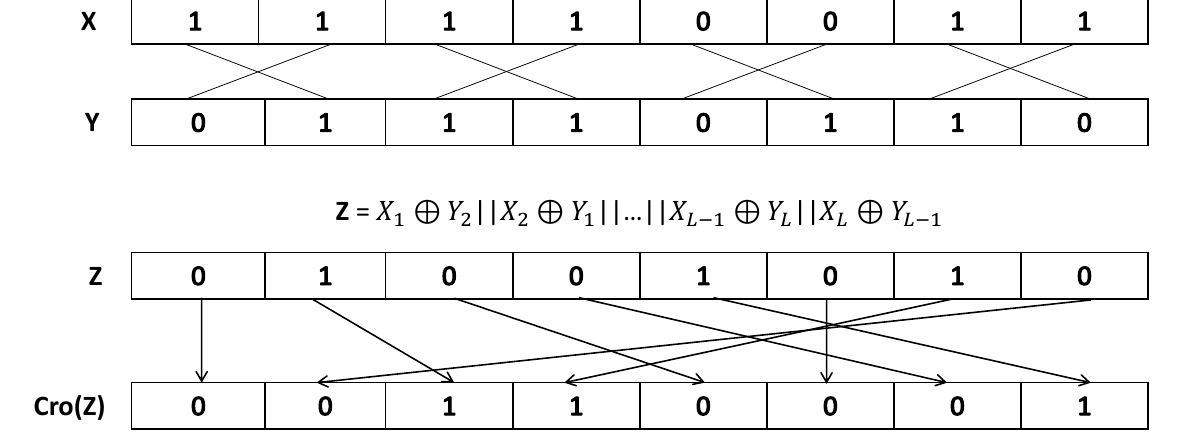
Figure 1. Cro ( · ) computation